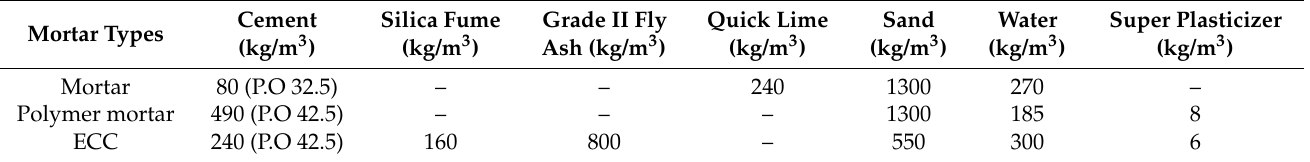
Table 2. Mix proportions of the concrete